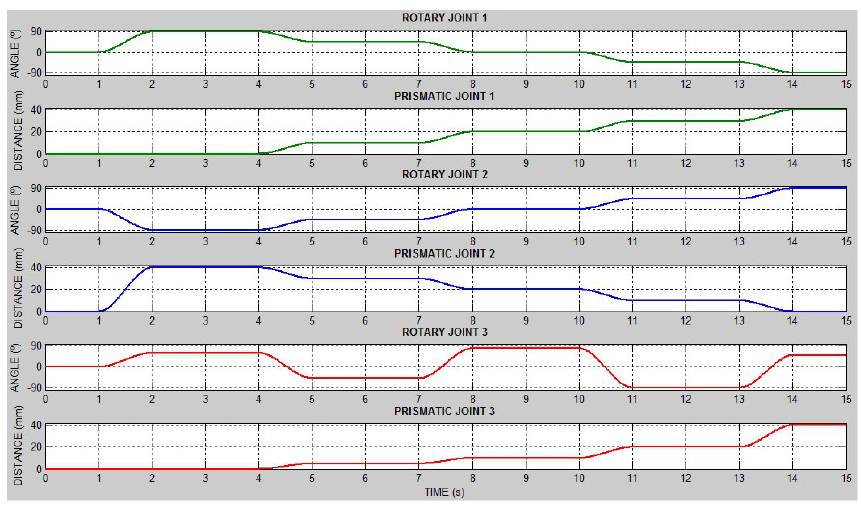
Figure 9. Visualization of the programmed joint trajectories.